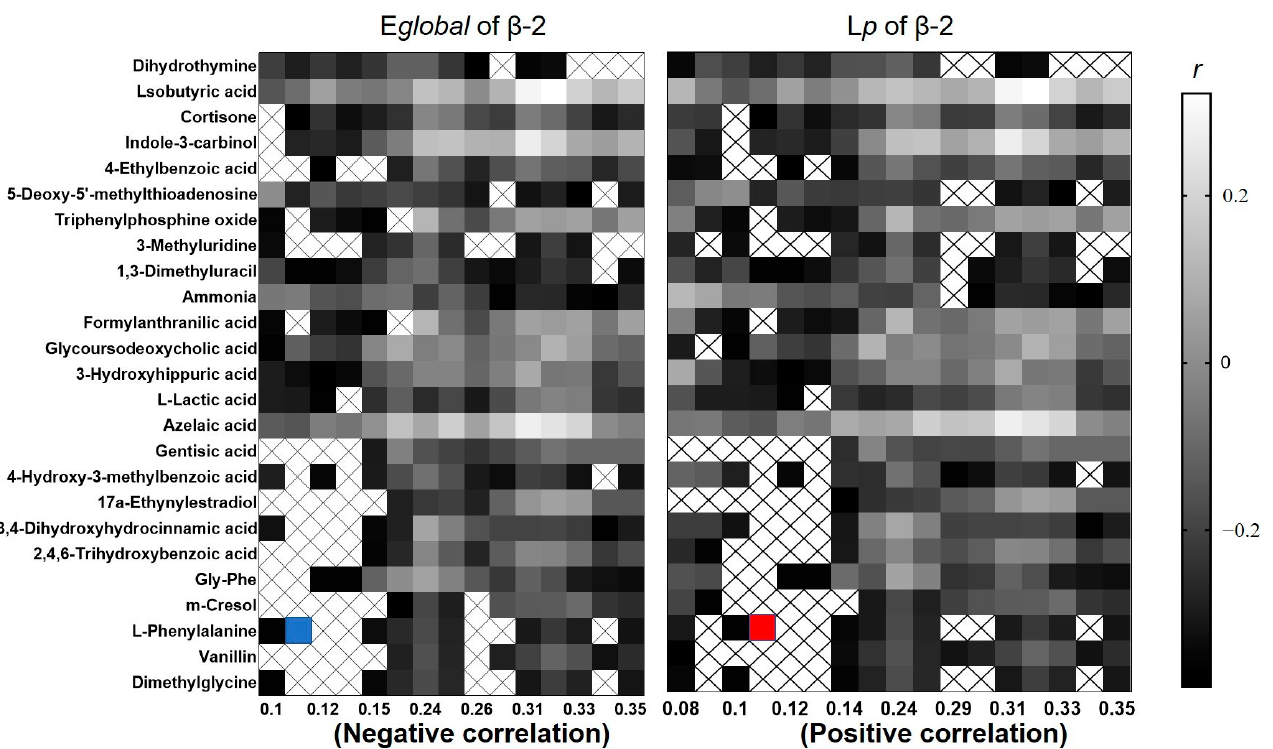
Figure 4. Correlation between E global and L p of functional brain network and differential metabolites; × represents a significant correlation. The maximum correlation (red and blue square) was found at the sparsity of 0.11.